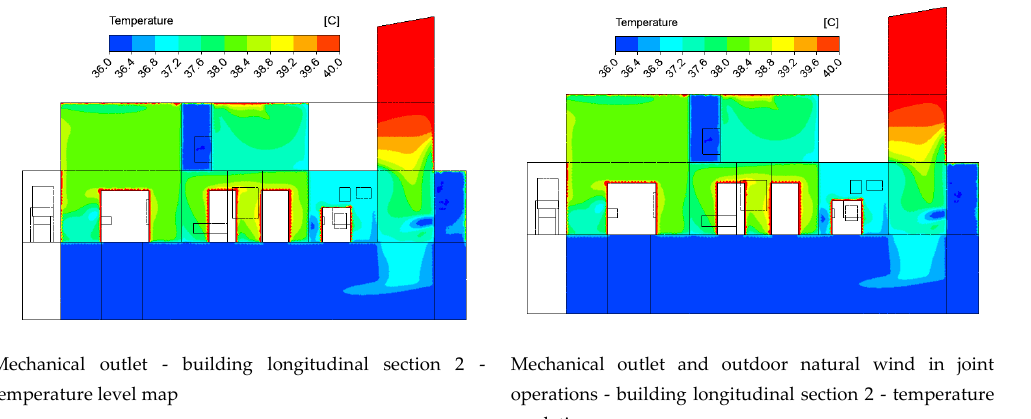
Figure 13. Indoor temperature distributions based on mechanical outlet or mechanical outlet + outdoor natural wind.